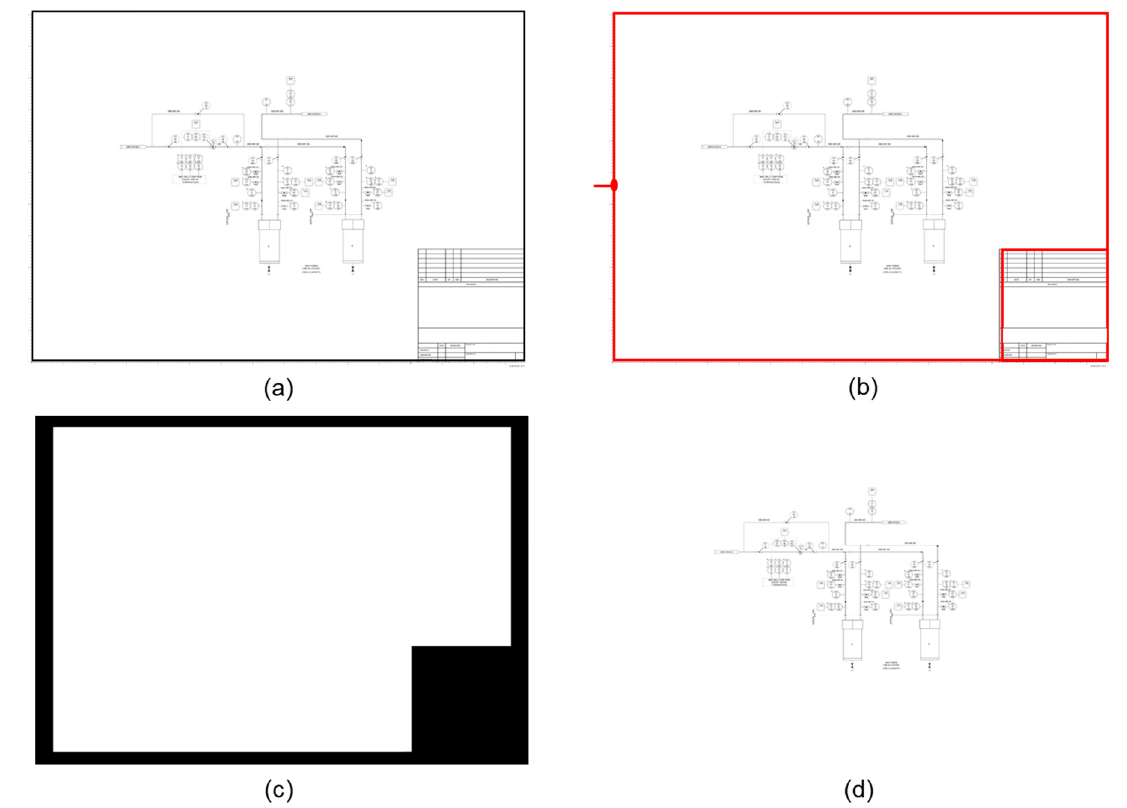
Figure 10. Removal of outline border and title area. ( a ) An image of P&ID. ( b ) After detecting one pixel of the outline, all connected pixel values are stored. ( c ) Detects and removes the title and outline area by performing the opening operation of the morphology operation. ( d ) Result of removing outline and title area of image drawing.